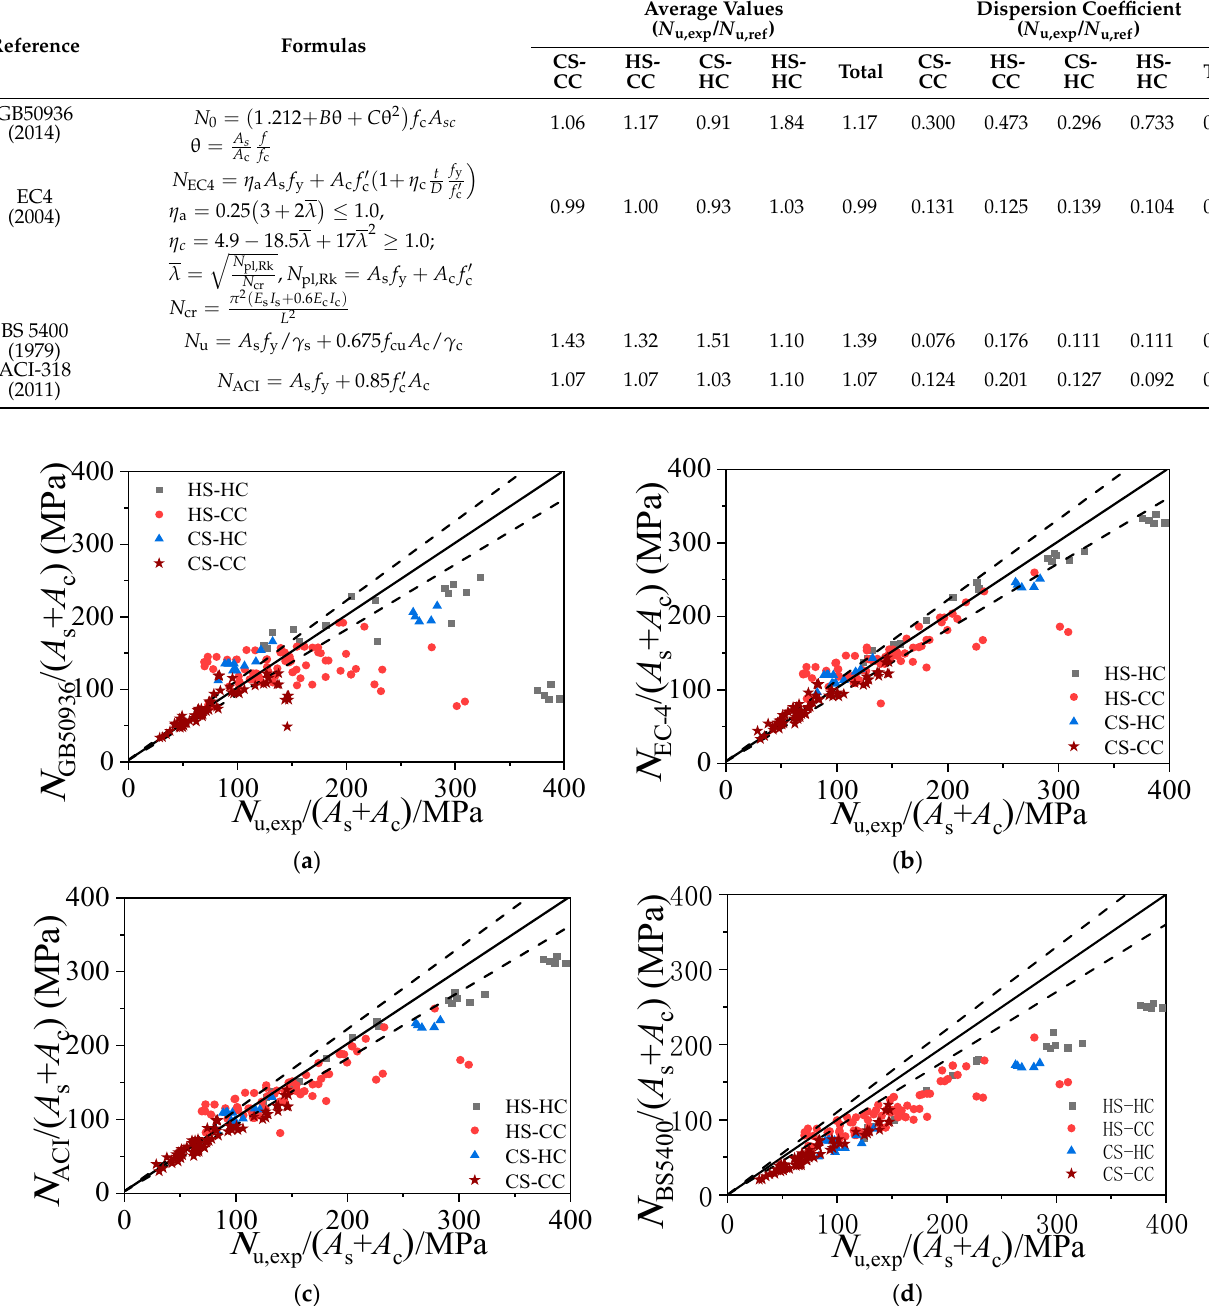
Figure 14. This is a figure. Schemes follow the same formatting. ( a ) Comparison of ultimate bearing stress obtained from test results and GB50936. ( b ) Comparison of ultimate bearing stress obtained from test results and EC4. ( c ) Comparison of ultimate bearing stress obtained from test results and ACI. ( d ) Comparison of ultimate bearing stress obtained from test results and BS5400. Table 3. Summary of available formulas in well-known national codes.